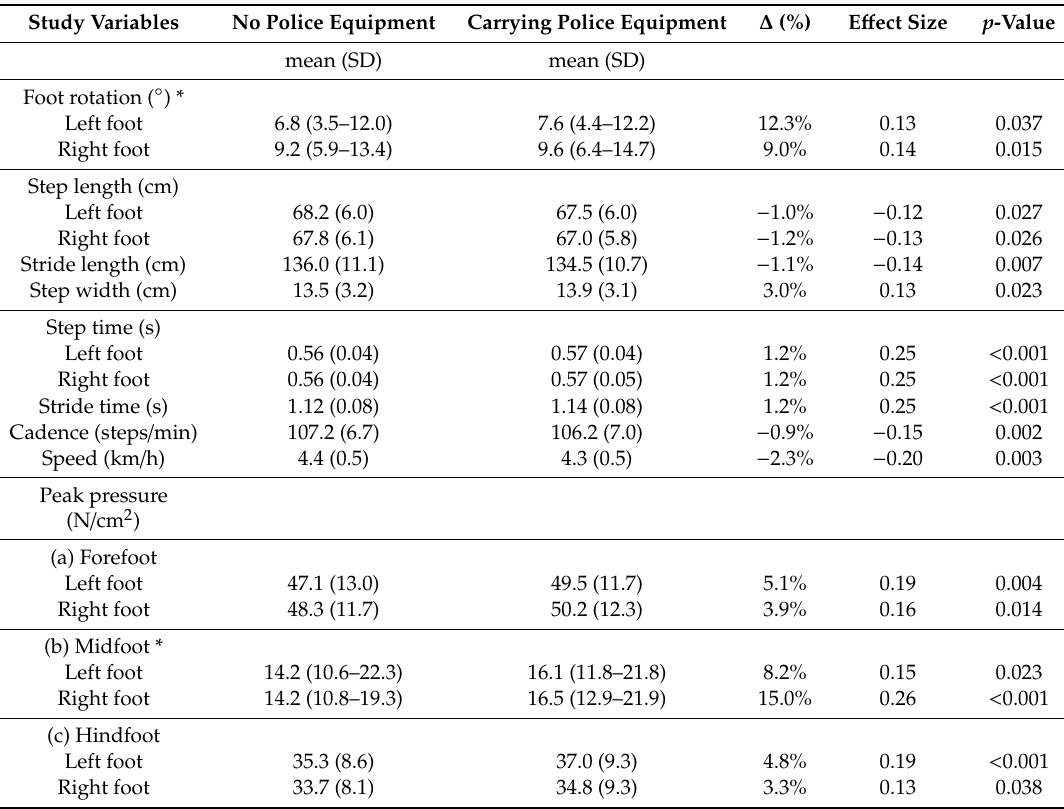
Table 2. E ff ects of carrying police equipment on spatiotemporal and kinetic gait parameters in men ( N =